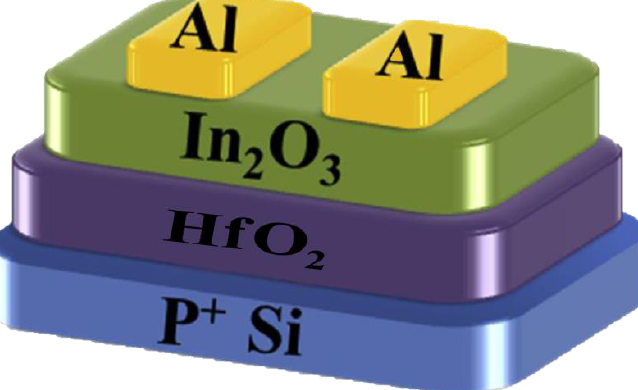
Figure 1. Schematic diagram of In 2 O 3 TFT with HfO 2 gate